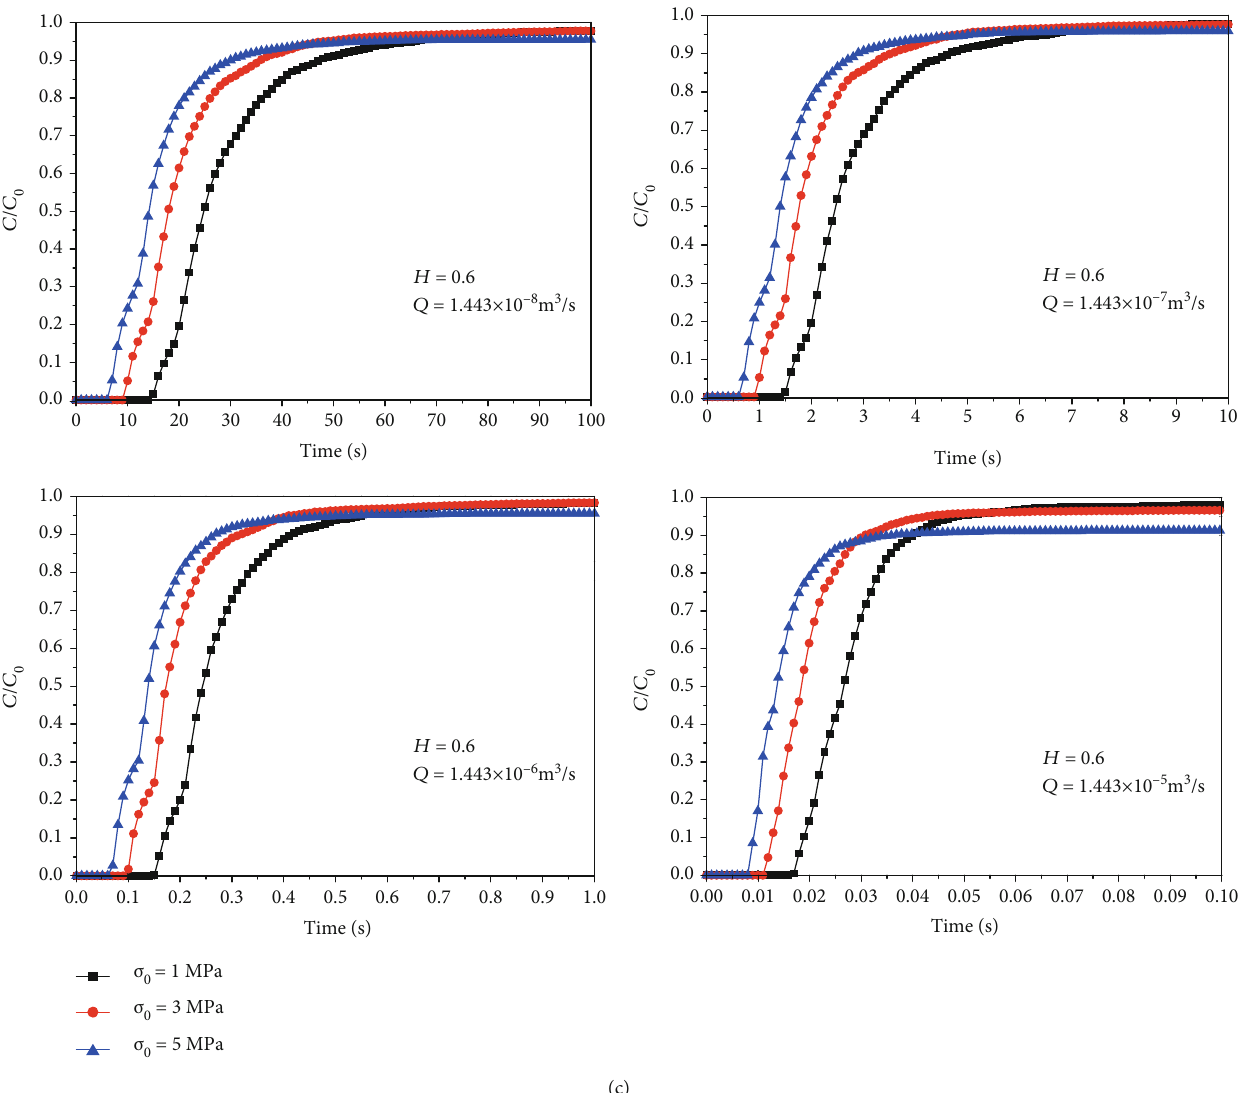
Figure 14: Breakthrough curves for di ff erent fracture models with di ff erent roughness coe ffi cients: (a) H = 0 : 5 , (b) H = 0 : 55 , and (c) H = 0 : 6